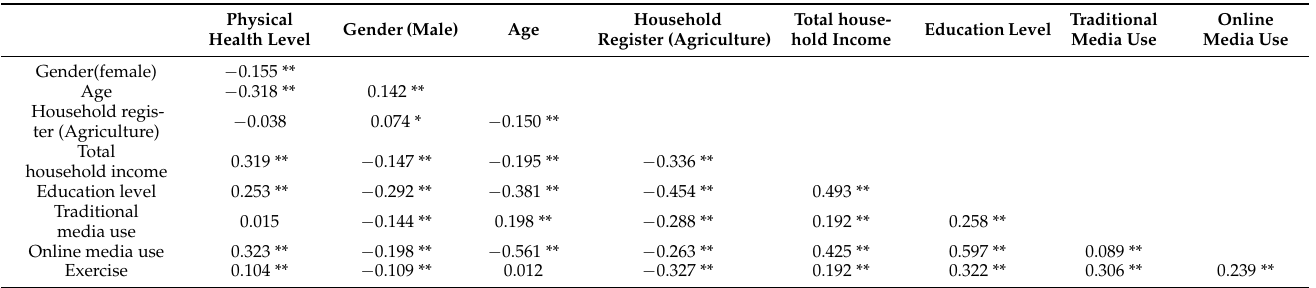
Table 5. Bivariate correlation between physical health level and other variables.